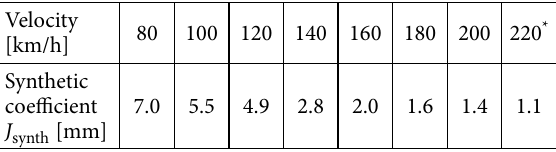
Table 1. Allowable deviations of track geometry synthetic